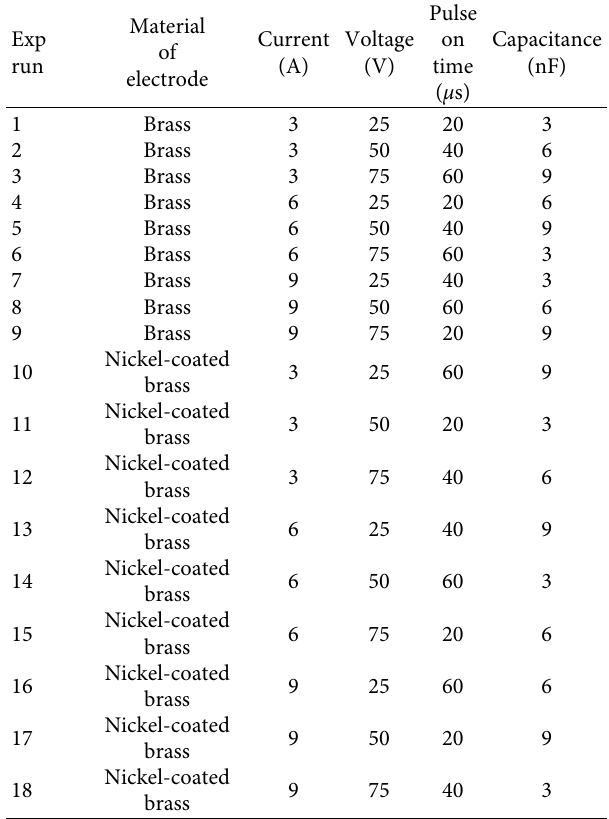
Table 1: Process parameter variables.